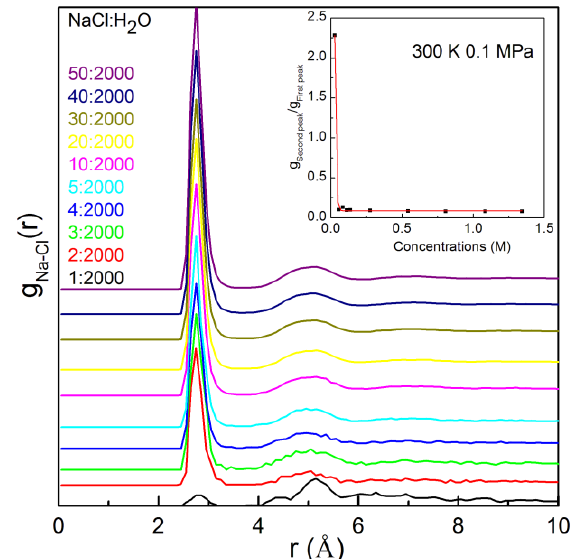
Figure 1. The calculated g Na-Cl(r) of various NaCl solutions. The inlet shows the dependence of the ratio of second peak to the first peak of g Na-Cl(r) on the NaCl concentrations.